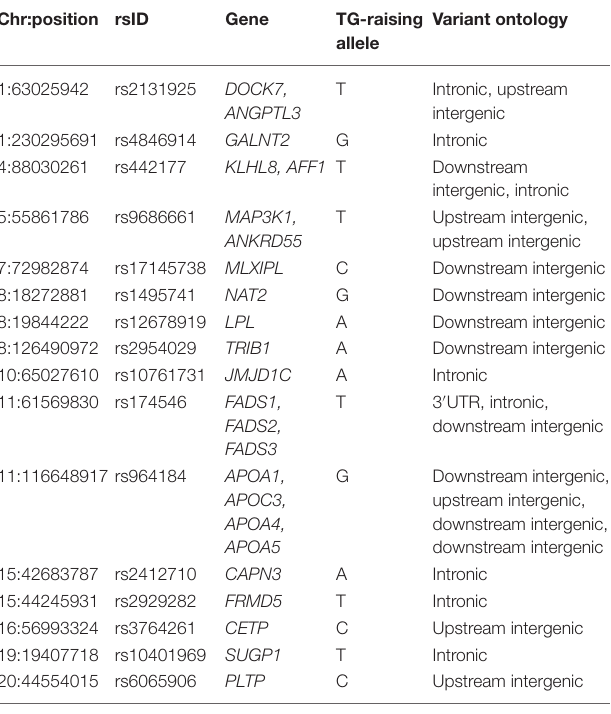
TABLE 2 | SNP loci considered in the recently published 16-SNP polygenic score used to characterize the genetic basis of hypertriglyceridemia phenotypes. Chr:position rsID Gene TG-raising Variant allele